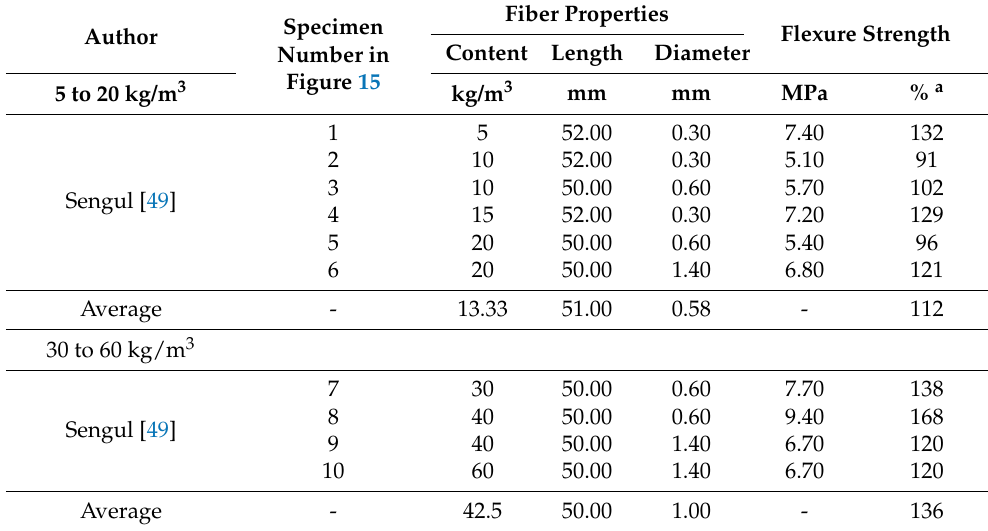
Table 11. Results of flexure strength’s percent comparison and fiber properties of the concrete incorporating RSF in kg/m 3